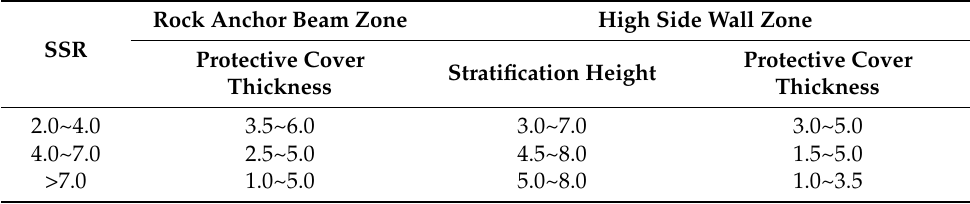
Table 4. Recommendations for excavation procedure design based on SSR